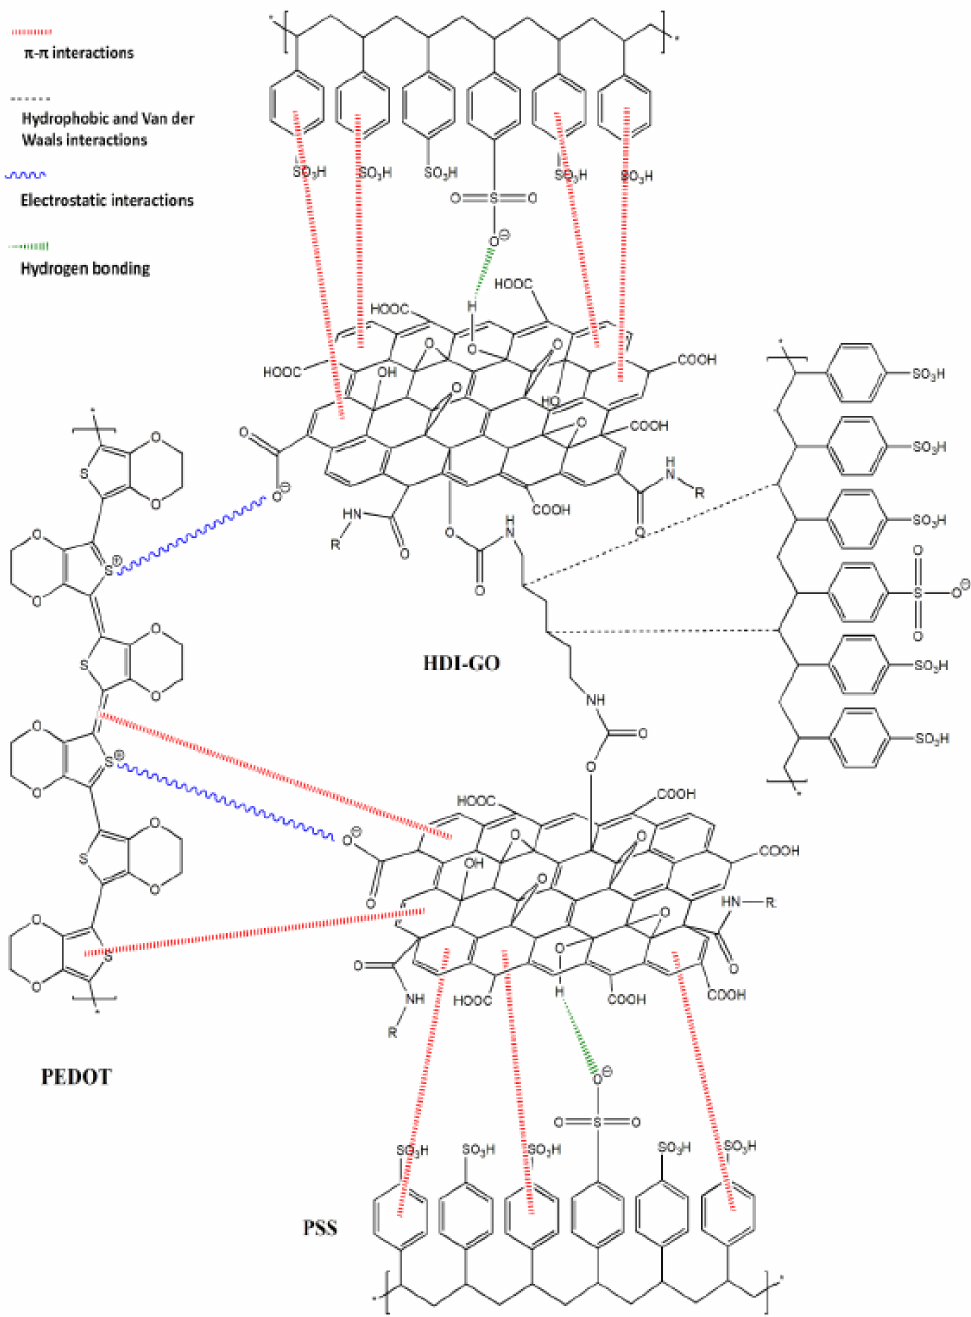
Scheme 2. Representation of the different types of interactions between PEDOT:PSS and